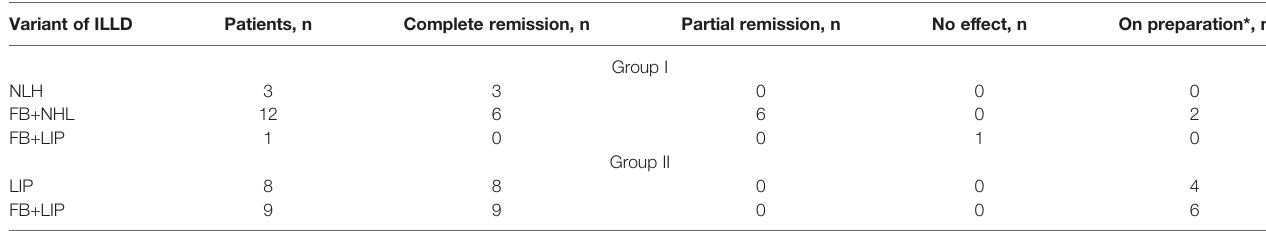
FB, follicular bron с hiolitis; LIP, lymphoid interstitial pneumonia; NLH, nodular lymphoid hyperplasia. *Follow up 10 ± 2 mo, n, number of